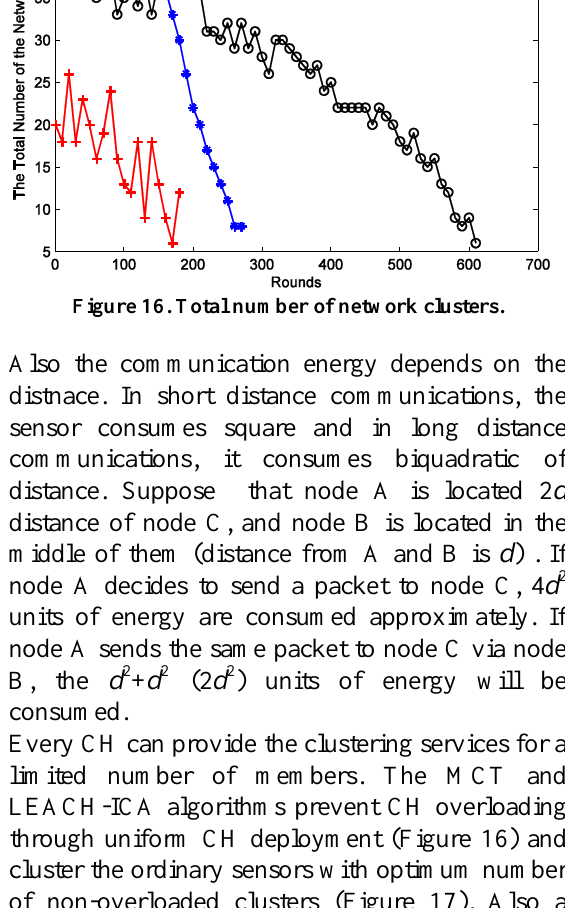
Figure 16. Total number of network clusters.